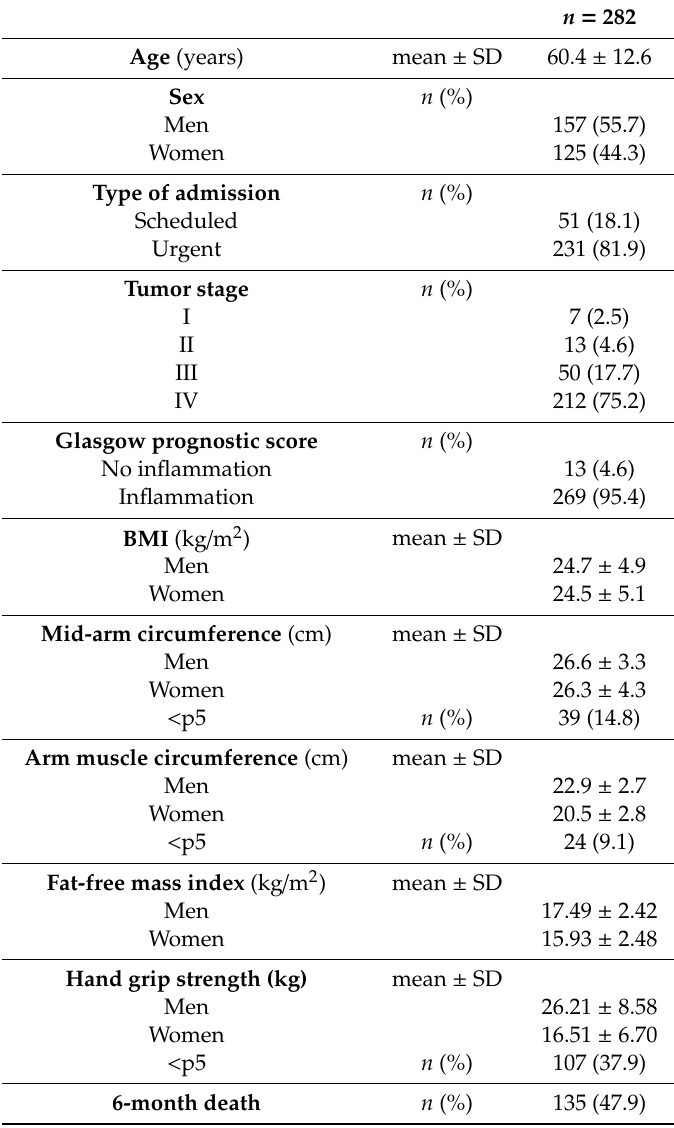
Table 1. General